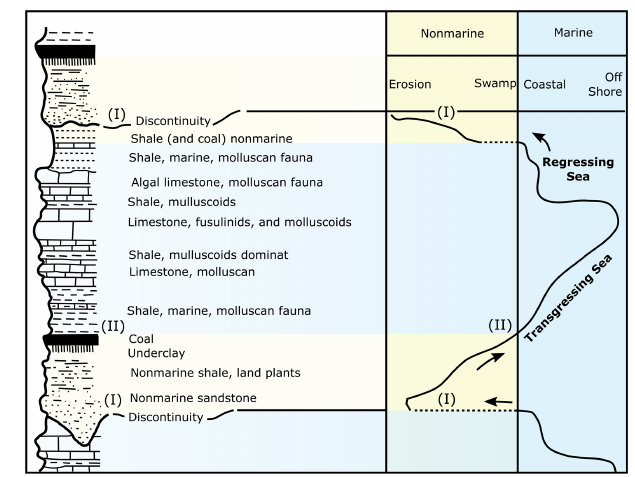
Figure 19. Representative section of cyclothems indicating the al- ternation of continental and marine paleoenvironments (modified from Moore, 1964). The alternatives of limits for cyclothems are (I) disconformities and (II) the transition from non-marine to marine conditions.